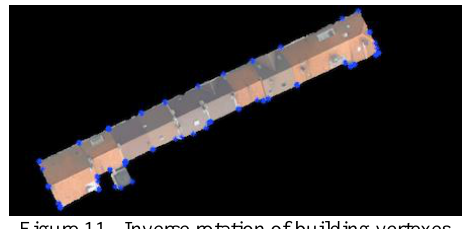
Figure 11 . Inverse rotation of building vertexes study area.